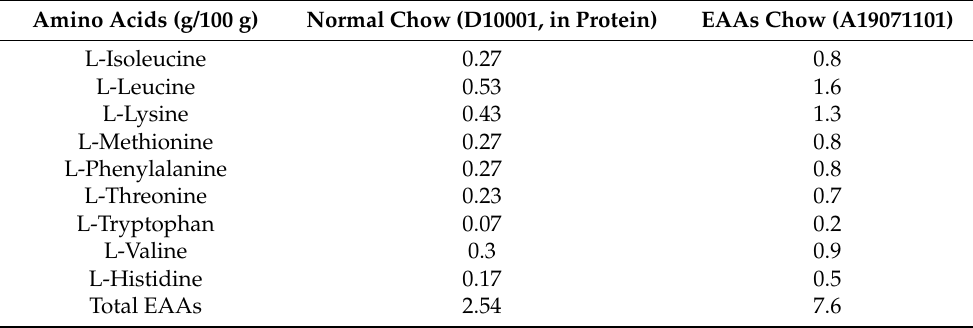
Table 1. EAA compositions of normal chow and EAA-enriched chow. Amino Acids (g/100 g) Normal Chow (D10001, in Protein) EAAs Chow